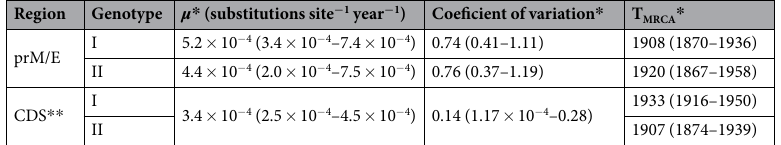
Table 1. Bayesian estimates of evolutionary parameters of the YFV American genotypes. * The 95% HPD is displayed in parentheses. ** Complete coding